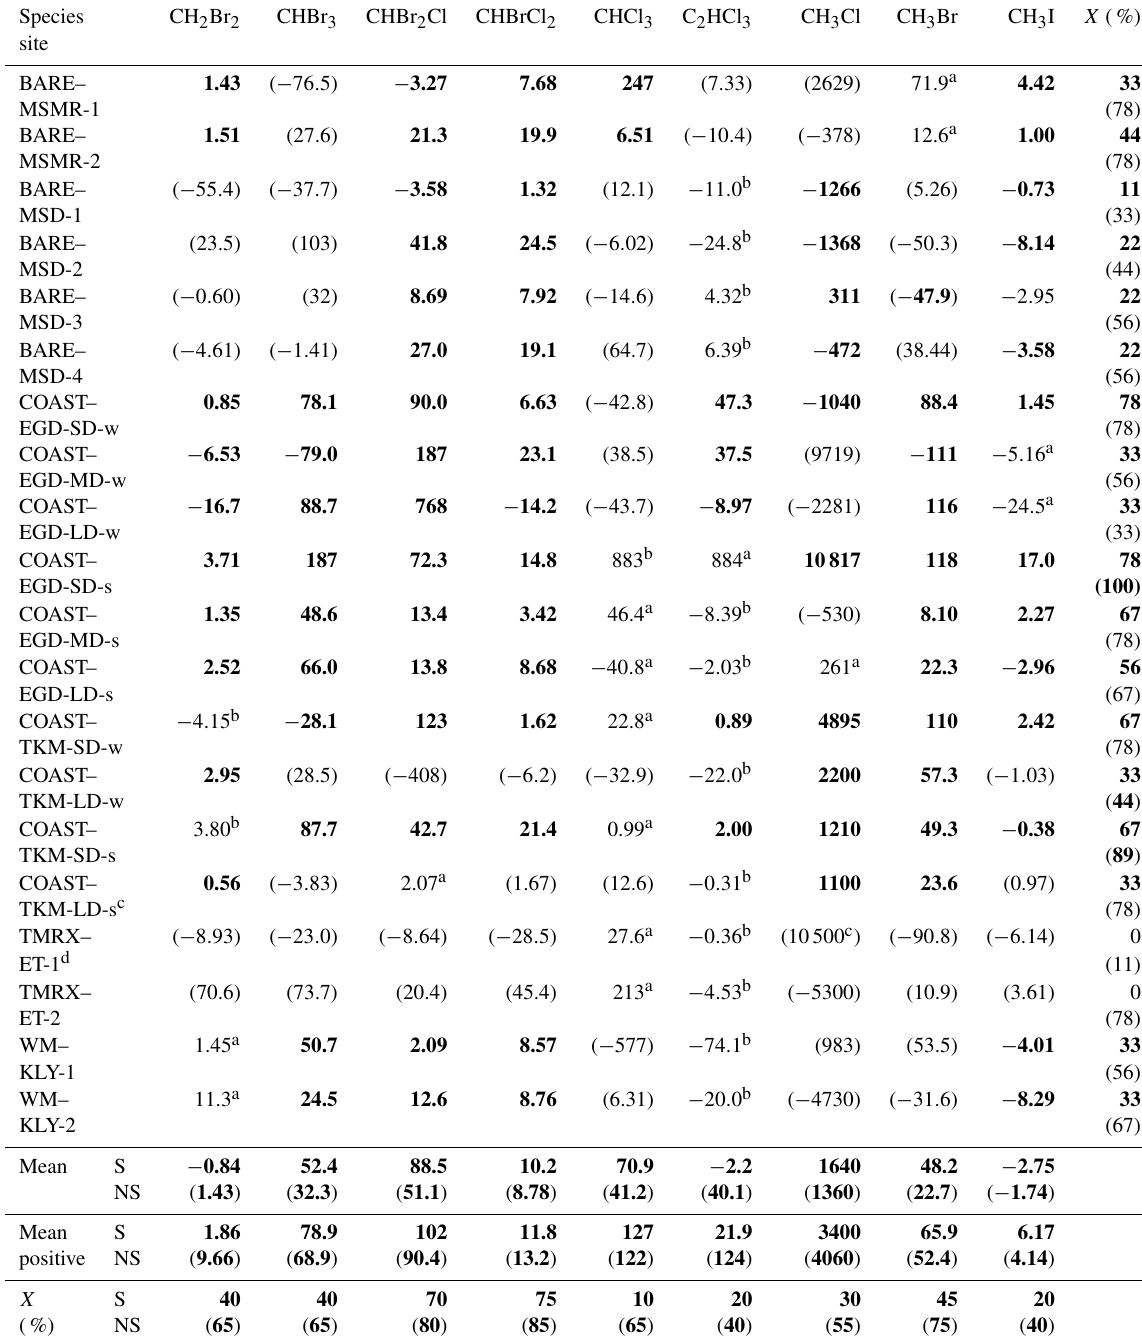
Table 2. VHOC fluxes for the different measurement sites. Shown is the measured flux (nmolm − 2 d − 1 ) obtained for the different measure- ments. Values in bold and in parentheses indicate that the related measurement site is a significant ( p <0.05) or non-significant ( p >0.15) net source or sink for the specific VHOC based on one-sample t test. Additional categories are defined below. These calculations assume COAST–EGD-SD and COAST–TKM-SD to be the same source (see Sect. 2.1.2). Also shown are the average flux (mean) and average posi- tive flux (mean positive) for all species, as well as the percentage of incidence of positive flux ( X ) out of total measured fluxes, individually for each site and each VHOC (See Table 1 for abbreviations of the different measurement sites). All presented values, including mean, mean positive and X include only fluxes associated with p <0.05 (bolded; S) and values associated with p ≥ 0 . 05 (presented in parentheses; NS), based on one-sample t